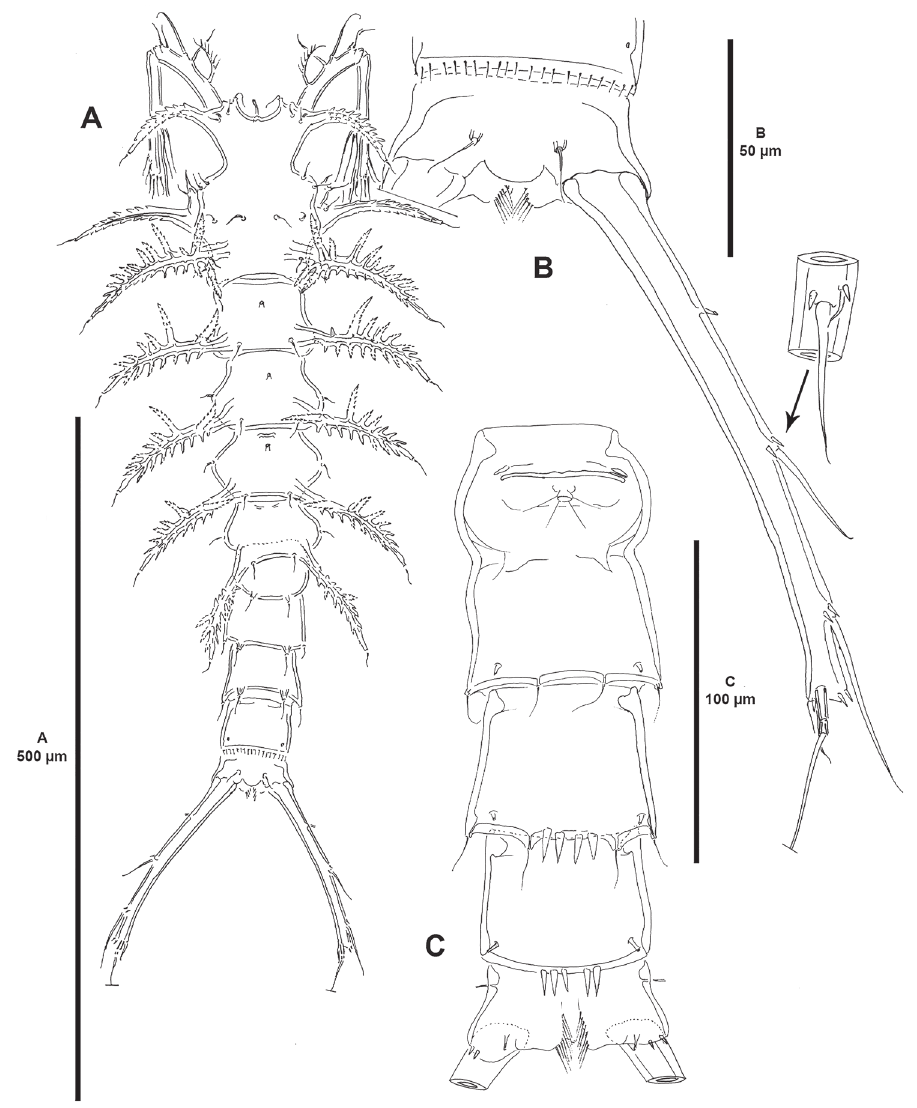
Figure 7. Dendropsyllus californiensis sp. n., female holotype. A habitus, dorsal B anal somite and right caudal ramus, dorsal, showing insert of lateral view of seta I and II C urosome, ventral, P5 bearing-somite and caudal rami